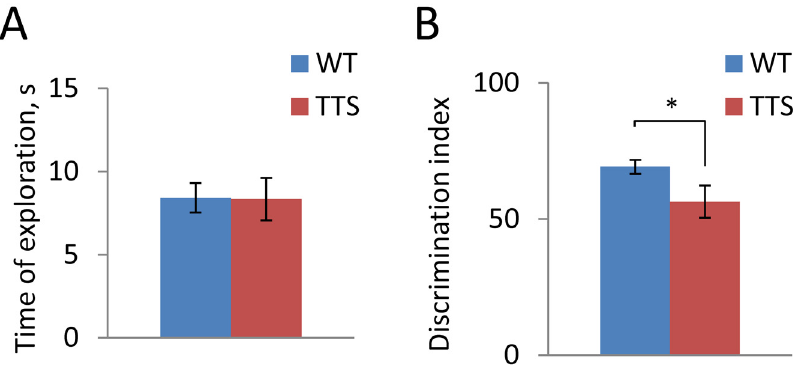
Fig 5. Novel object recognition. A: The time spent on investigation of the objects during the testing phase of the experiment; B: Discrimination index. Mean ± SEM; * p < 0.05, significantly different from WT mice.